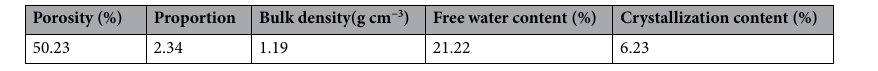
Table 2. Basic physical properties of phosphogypsum.